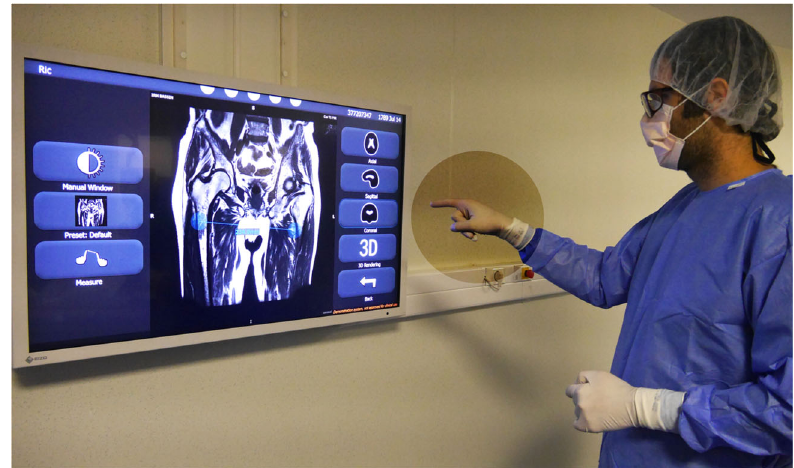
for operating rooms, Fluid (Therapixel, Paris, France). The surgeon or the interventional radiologist interacts in sterile conditions with gloved hands. The viewer interface isredesigned without a pointer; the tools are selected with lateral movements